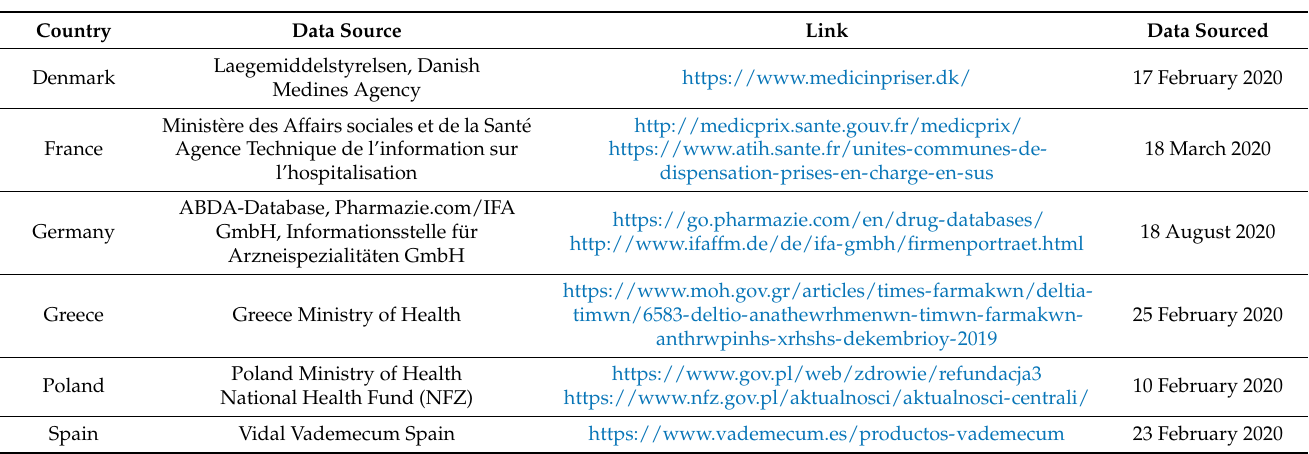
Table 2. Price Data